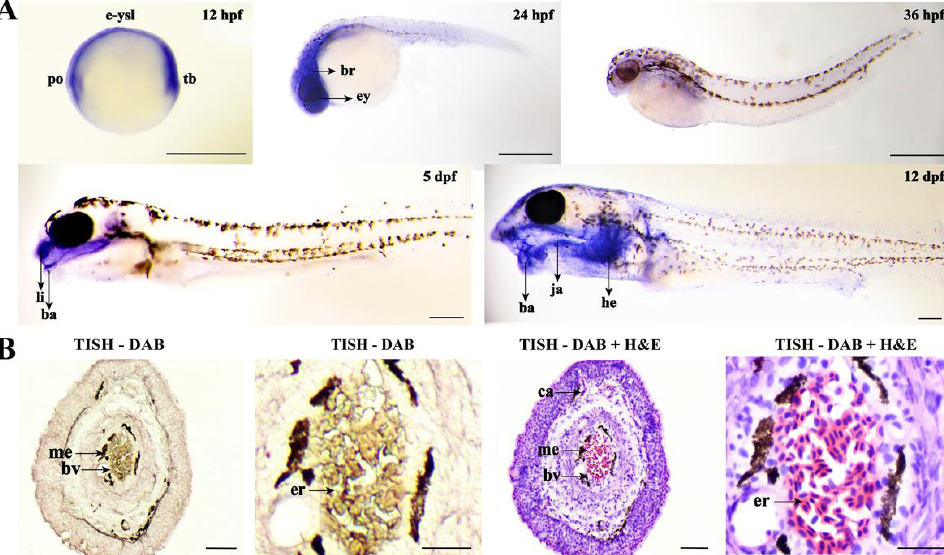
Figure 6. The localization of fn1b in loach. ( A ) Whole-mount in situ hybridization of fn1b in loach embryos of different developmental stages, including 12 hpf, 24 hpf, 36 hpf, 5 dpf, and 12 dpf. hpf, hours post fertilization; dpf, days post fertilization; po, polster; tb, tail bud; e-ysl, external yolk syn- cytial layer; br, brain; ey, eye; li, lip; ba, barbels; he, heart; ja, jaw. Scale bar = 1 mm. ( B ) Tissue in situ hybridization (TISH) of fn1b in loach barbels. Brown color sig nifies the signals. DAB, 3,3′ -diamino- benzidine tetrahydrochloride; H&E, hematoxylin and eosin; bv, blood vessel; me, melanocytes; er, erythrocytes; ca, capillary. The scale bars of the left and the right pictures indicated 100 μm and 10 μm, respectively.